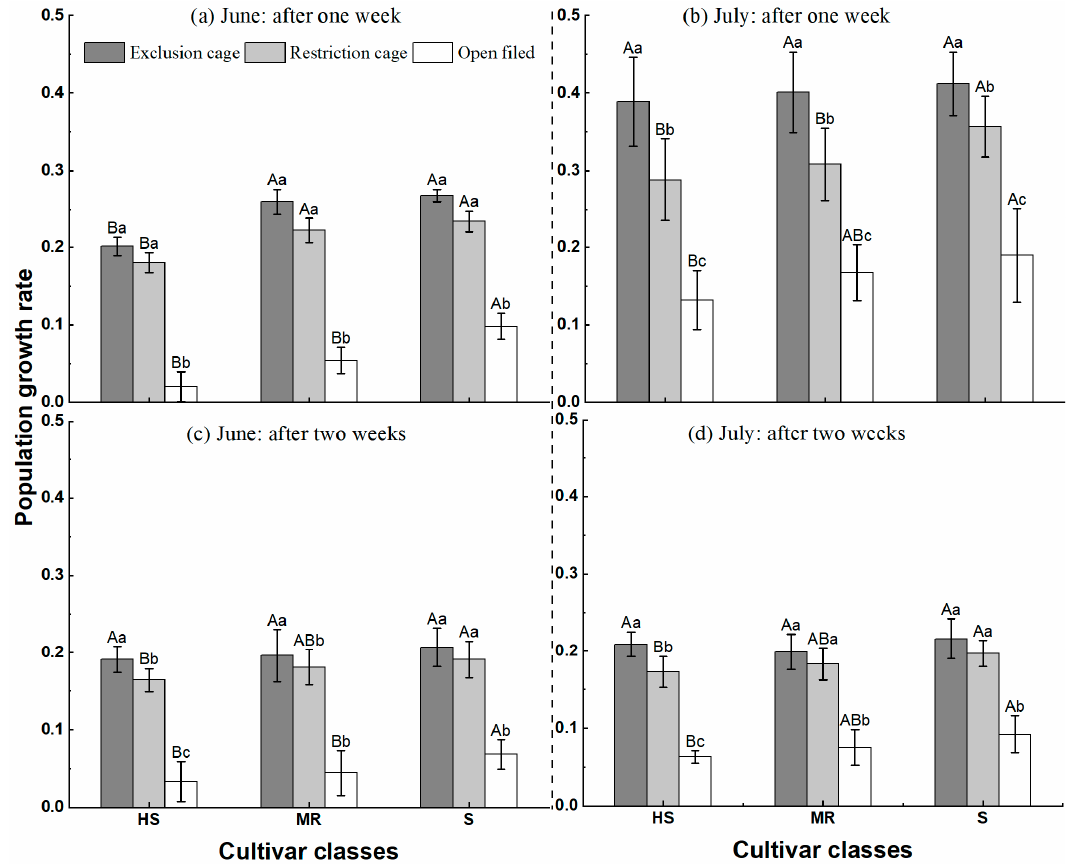
Figure 3. The mean (±SEM) population growth rate of pea aphid, Acyrthosiphon pisum , across nine different alfalfa cultivars and three caging treatments and categorized by three cultivar classes (HS = Highly susceptible; MR = Moderate Resistance; S = Susceptible) to aphids in a field experiment in Ningxia Province, China, in June (1st harvest) and July (2nd harvest) 2019. Note: The left side of the dashed line represents the period in June after the first harvests, and the right side represents the period in July after the second harvest. Different capital letters indicate significant differences among cultivar classes ( p < 0.05), and different lower-case letters show significant differences among cage ( p <